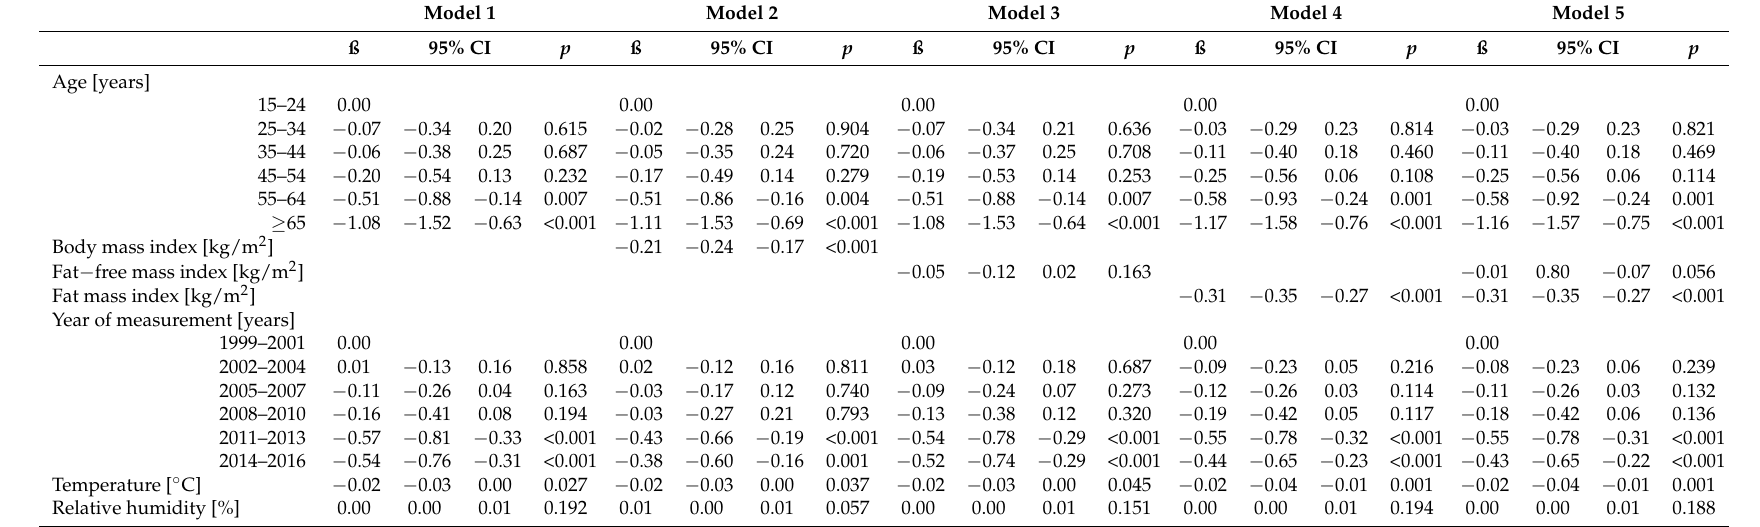
Table 2. Multivariate mixed linear regression to predict changes in running speed in women (377 participants, 1419